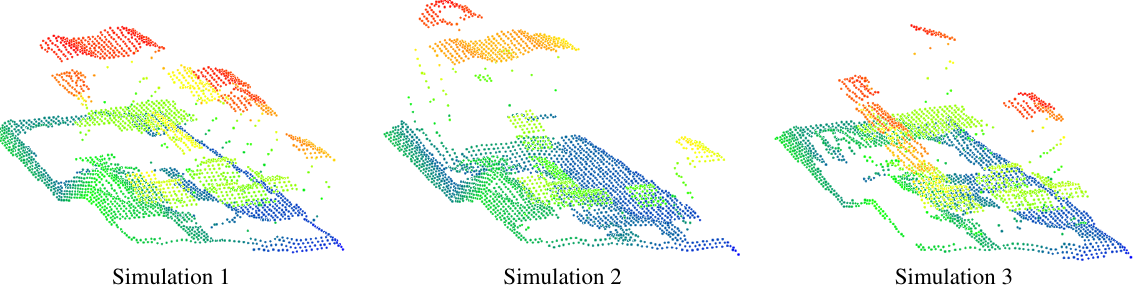
Figure 3. Variability of PCs generated by the simulator over the same district of Lyon. Elevation is shown in a relative color range.